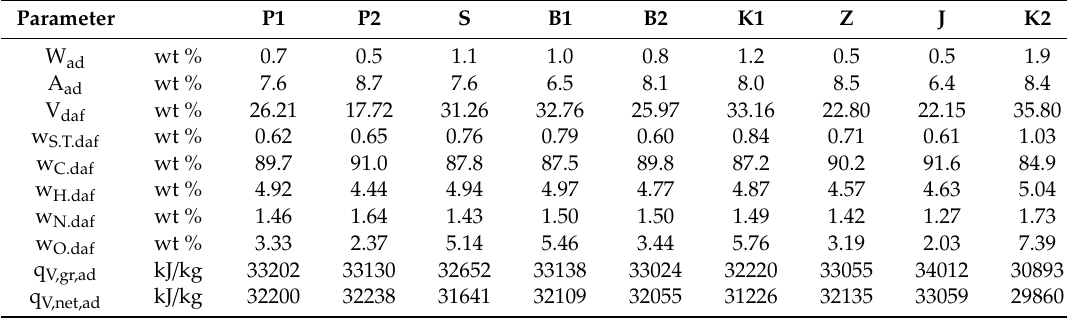
Table 2. Properties of tested coals.